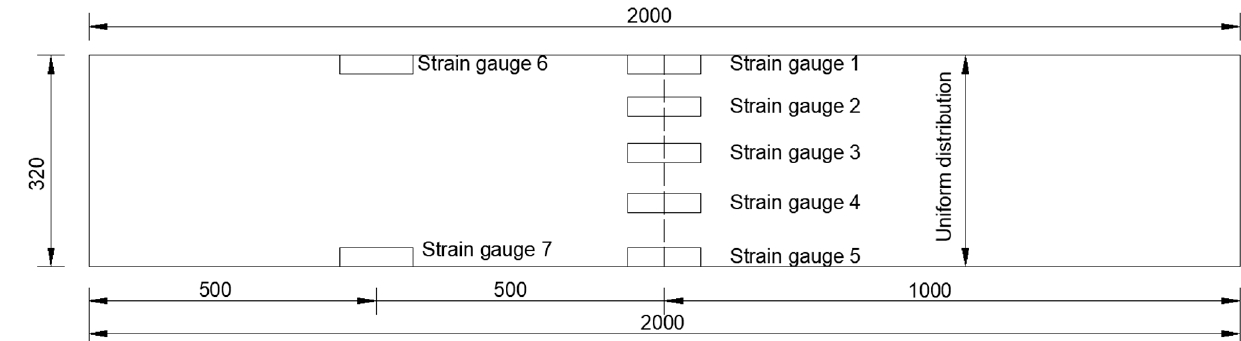
Figure 2. Elevation of test beam layout of electronic strain gauges (mm). Displacement test (dynamic and static displacement): The dynamic and static displace- ments at both ends and at the midspan of the test beam under static and fatigue loads were measured. One displacement meter was placed at each end of the test beam, and one was placed at each side of the transverse bridge in the midspan, totaling 4 displacement meters. Figure 3 shows the specific layout. The measurement range of the resistance displacement sensor is 0–50 mm, and the accuracy is ± 0.1% F.S.